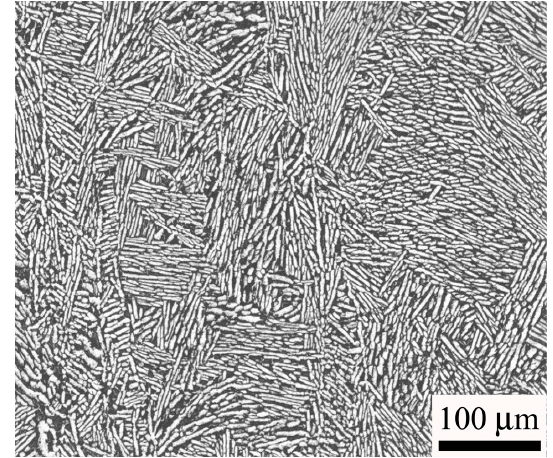
Figure 2. Microstructure of the Ti-6Al-2Sn-2Zr-3Mo-X alloy.